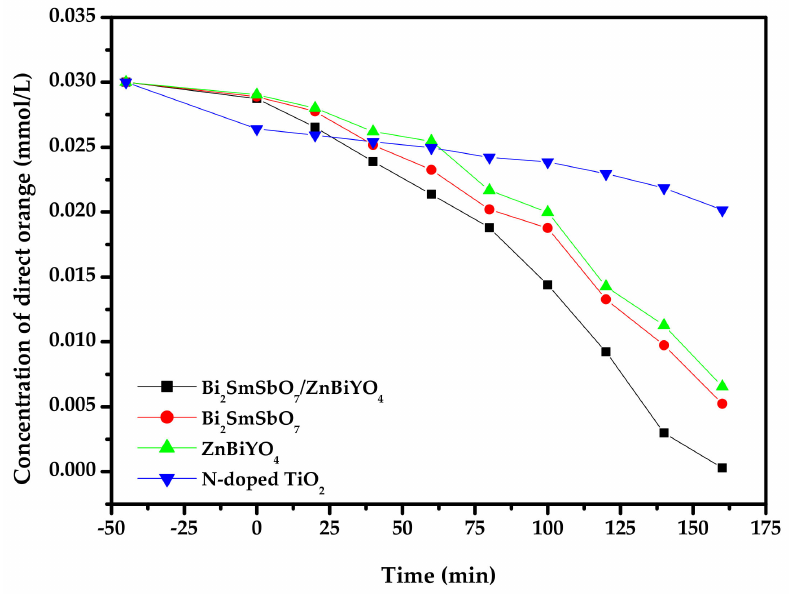
Figure 12. Concentration variation curves of DO during PD of DO with Bi 2 SmSbO 7 /ZnBiYO 4 heterojunction as catalyst or with Bi 2 SmSbO 7 , ZnBiYO 4 , N-doped TiO 2 as catalyst under